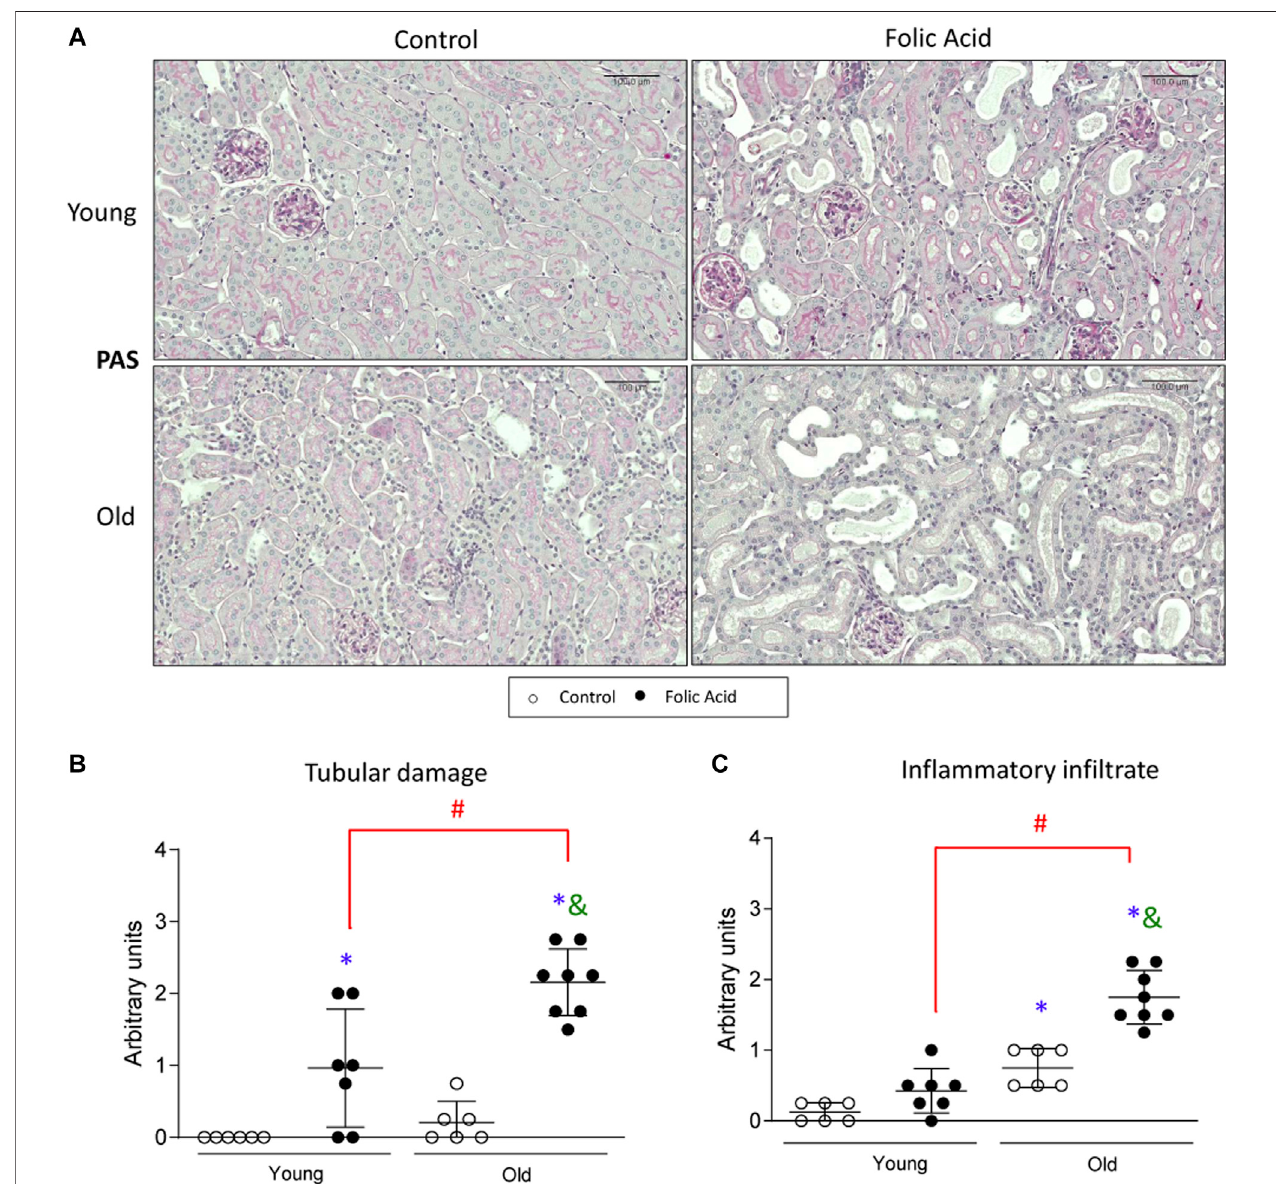
FIGURE 1 | Histological characterization of renal lesions in the acute phase of the folic acid nephropathy in young and old mice. Folic Acid (FA; 125 mg/kg) was injected in 3-months-old (Young) and 1-year-old (Old) C57BL/6 mice and kidneys were studied after 48 h. The morphological lesions were evaluated by Periodic Acid- Schiff stained kidney sections. (A) Figure shows representative micrographs from each group and the quanti fi cation, from 0 to 4, of (B) tubular damage and (C) in fl ammatory in fi ltrate. Scale bars (cid:2) 100 μ m. Data are shown as arbitrary units and expressed as mean ± SD of n (cid:2) 6 – 8 animals per group. * p < 0.05 vs. control young mice, # p < 0.05 vs. FA-injected young mice, & p < 0.05 vs. control old mice. The non-parametric Kruskal-Wallis statistical test was